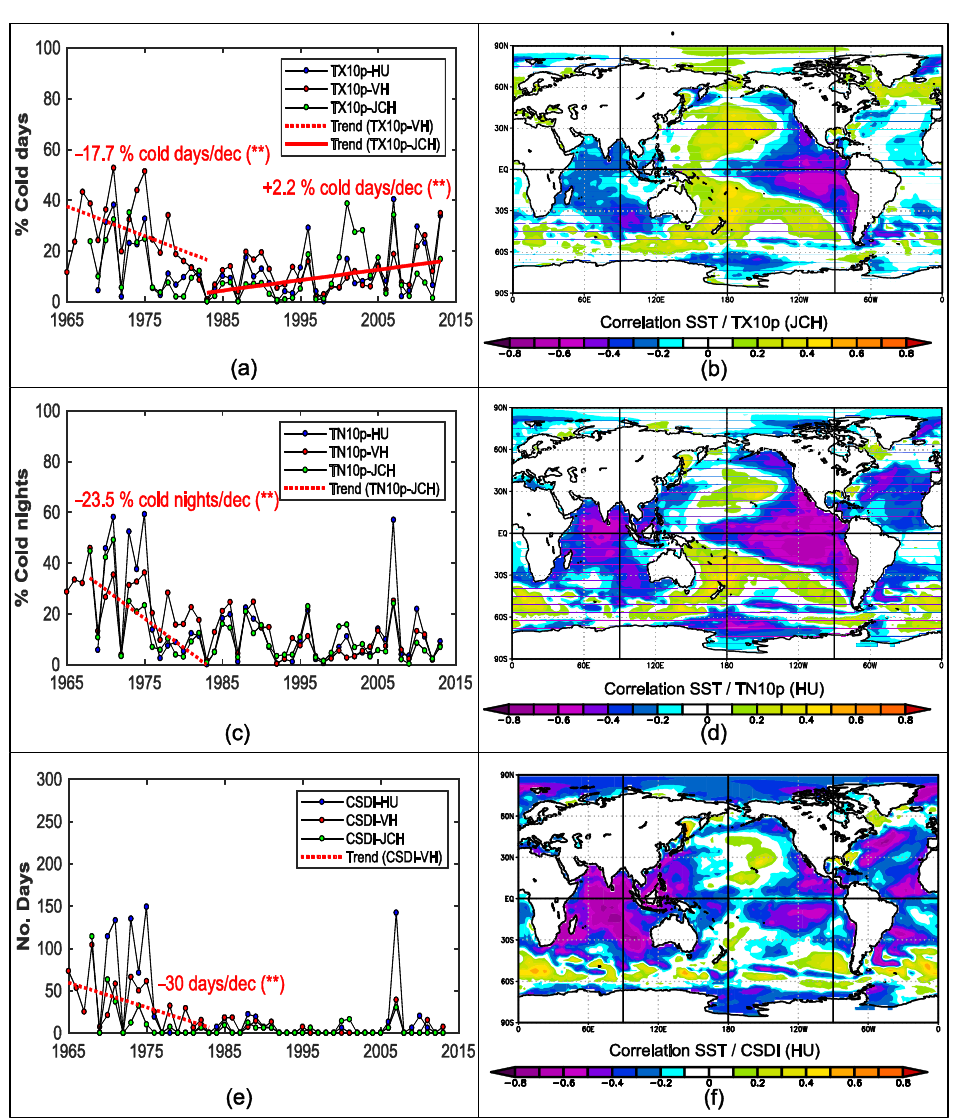
Figure 9. Variability and trends of extreme temperature indices: ( a ) TX10p, ( c ) TN10p, and ( e ) CSDI. Spatial field of annual correlations between Sea Surface Temperature (SST) and ( b ) TX10p, ( d ) TN10p, and ( f ) CSDI for the period 1965–2013. HU, VH, and JCH station. ** Statistically significant trends at the 95% confidence level ( p < 0.05). NCEP/NCAR Reanalysis. Source: NOAA/ESRL Physical Sciences Laboratory.